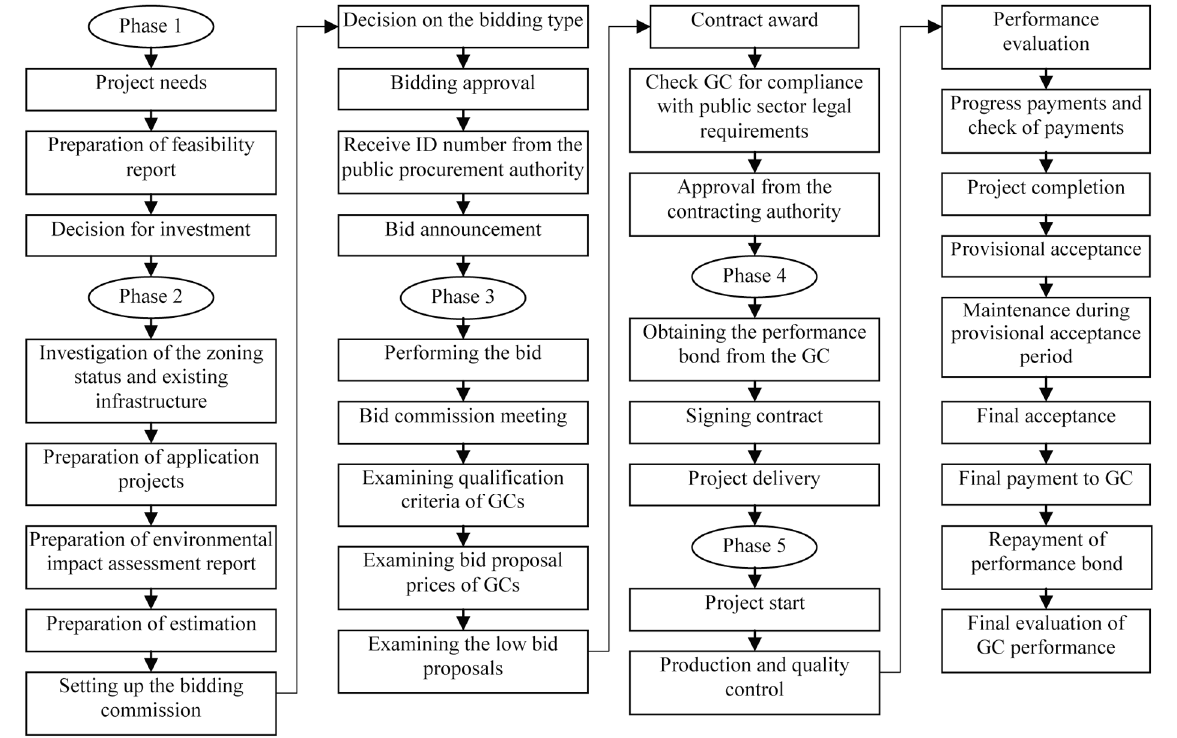
Fig. 1. Project delivery of a typical public construction project in